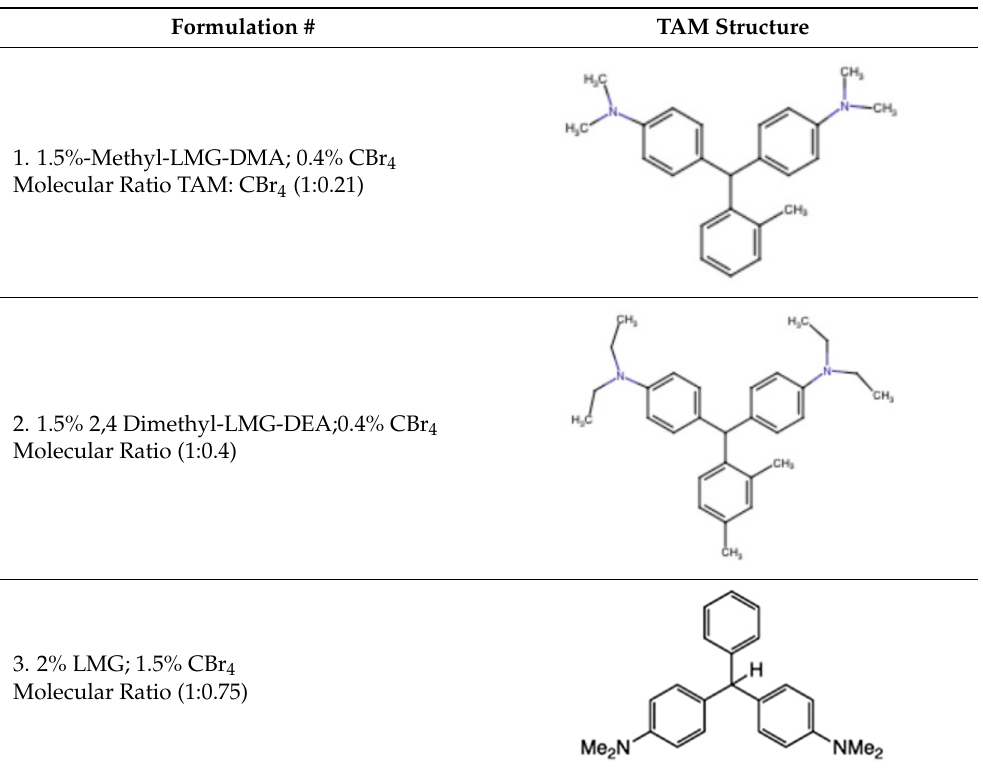
Table 1. Three formulations studied for reusability.